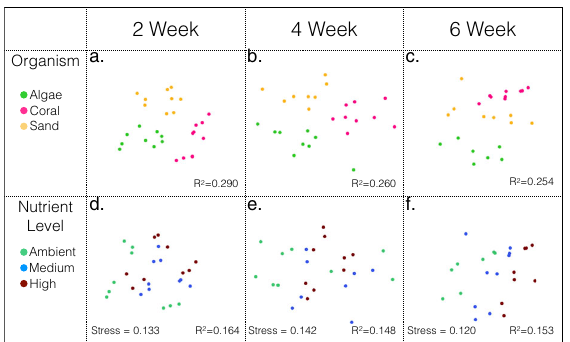
Fig. 3 Effects of benthic organism and nutrient enrichment on bio fi lm communities within each time point. At each time point, both nutrient treatment and benthic organism signi fi cantly in fl u- ence bio fi lm community structure ( p < 0.001). Organism ( a – c ) is a better predictor of bio fi lm community than nutrient level ( d – f ) across each time point. A signi fi cant interaction between organism and nutrient level is also observed at each time point: 2 week ( R 2 = 0.140, p = 0.003), 4 week ( R 2 = 0.144, p = 0.031) and 6 week ( R 2 = 0.156 & p = 0.006), indicating that nutrients affected community structure differentially according to the benthic organism